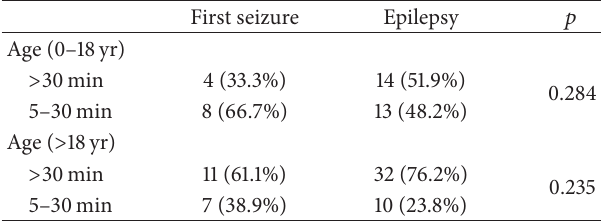
Table 2: Characteristics of patients with status epilepticus.